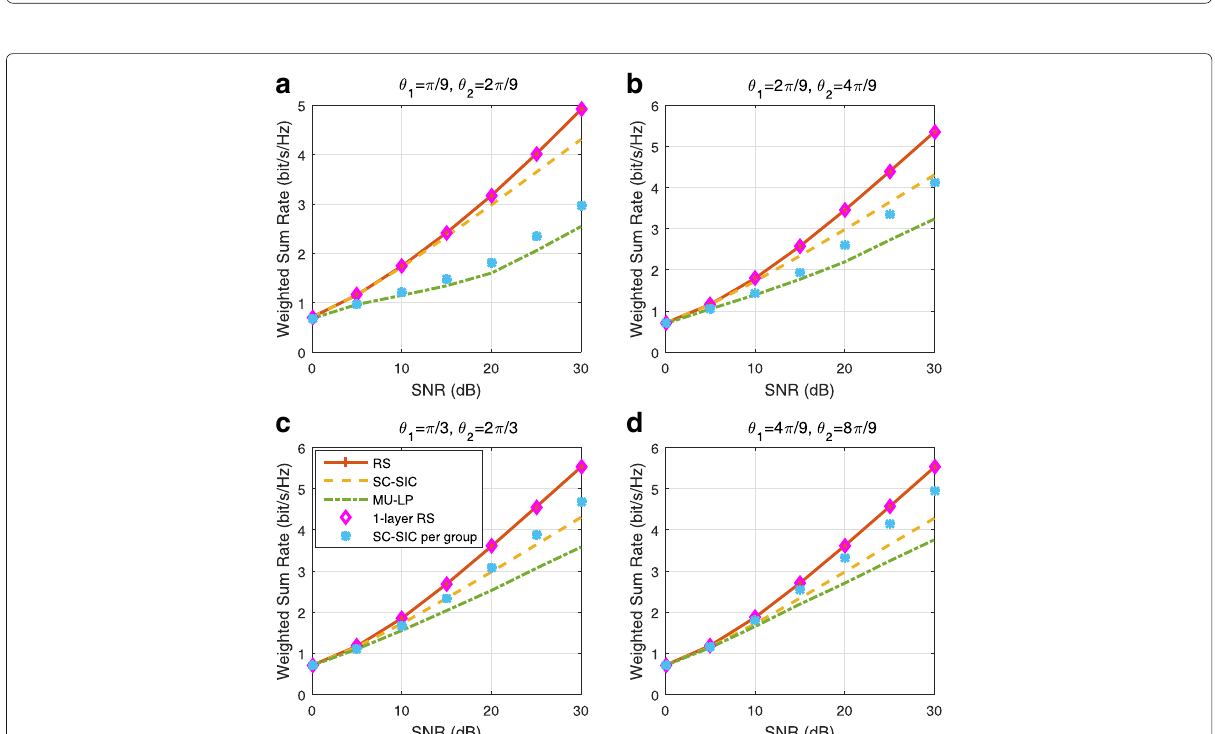
Fig. 53 Weighted sum rate versus SNR comparison of different strategies for overloaded three-user deployment with imperfect CSIT, γ 1 = γ 2 = 1, u 1 = 0.4, u 2 = 0.3, u 3 = 0.3, N t = 2, r th = [0.02,0.08,0.19,0.3,0.4,0.4,0.4] bit/s/Hz. a θ 1 = π/ 9, θ 2 = 2 π/ 9. b θ 1 = 2 π/ 9, θ 2 = 4 π/ 9. c θ 1 = π/ 3, θ 2 = 2 π/ 3. d θ 1 = 4 π/ 9, θ 2 = 8 π/